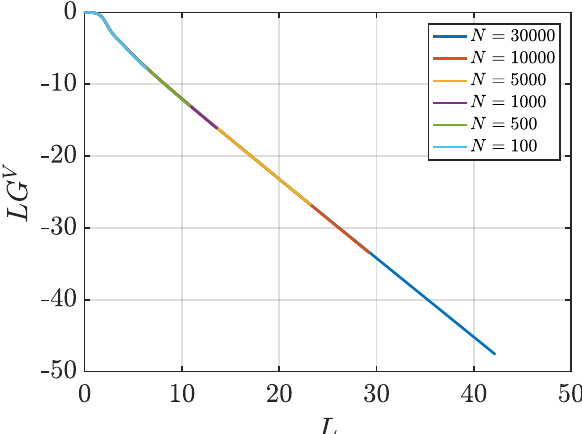
Figure 8. KB integrals of finite subvolumes multiplied by L , LG V (Equation (4)) vs. L for a LJ fluid at T = 2 and ρ = 0.4 (dimensionless units). The values of G V are computed for systems with varying number of molecules N . The used RDFs are provided in Figure